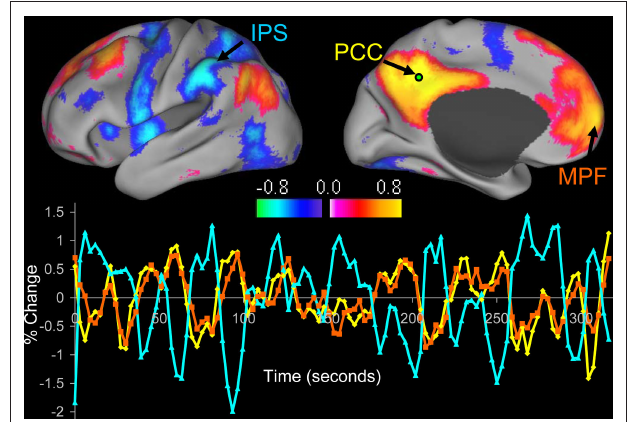
FIguRe 1 | Resting state functional connectivity reveals correlations and anticorrelations with the default mode network. Correlations between a seed region in the posterior cingulate/precuneus (PCC) and all other voxels in the brain for a single subject during resting fixation. Both correlations (positive values) and anticorrelations (negative values) are shown, thresholded at R = 0.3. The time course for a single run is shown for the seed region (PCC, yellow), a region positively correlated with this seed region in the medial prefrontal cortex (MPF, orange), and a region negatively correlated with the seed region in the intraparietal sulcus (IPS, blue). Reproduced with permission from (Fox et al.,